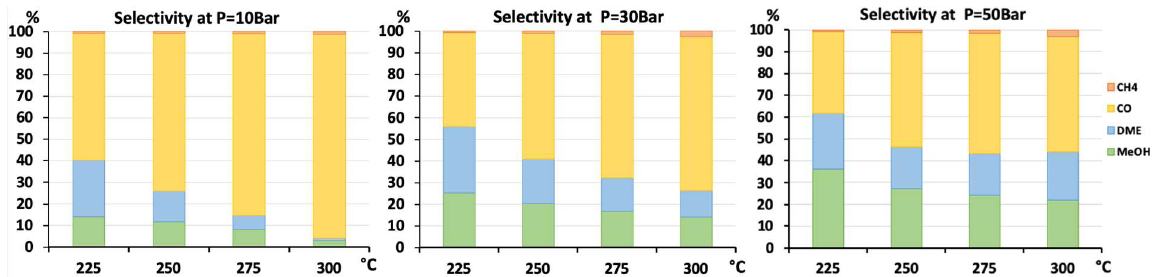
Figure 6. Selectivity to CH 4 , CO, DME, and methanol for AlNFs-Cu catalyst containing 10wt.% of Cu at pressures of 10, 30, and 50 bar and temperatures of 225, 250, 275, and 300 °C.